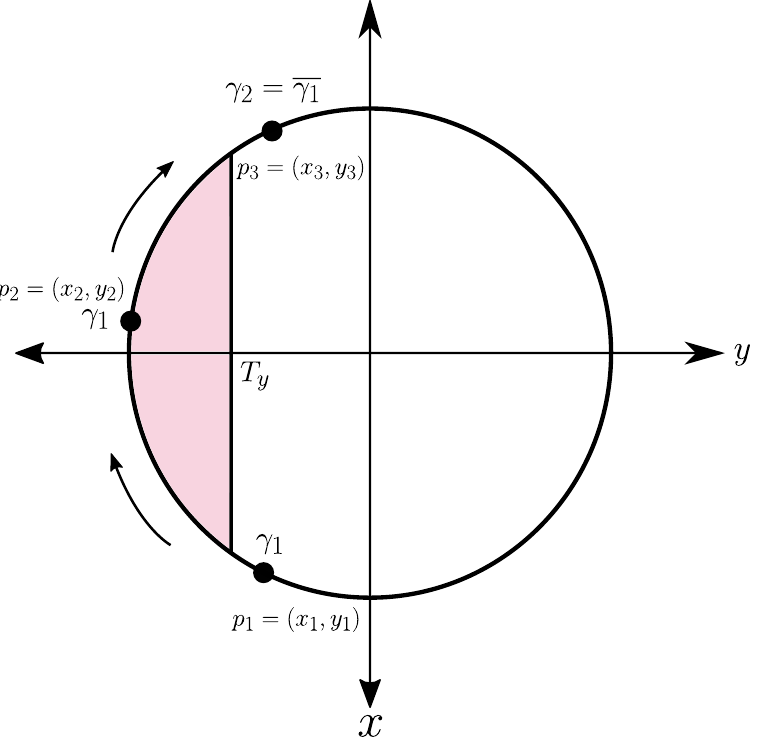
Figure 6. Pivoting phase is determined solely by transitions from outside to within the shaded region, determined by T y . As the commanded position coordinates shift from p 1 to p 2 , the cursor enters the shaded region and the y position is less than T y . When the cursor next leaves the shaded region, for example to p 3 , the phases of the rotation is toggled, which alternates which set of three legs are